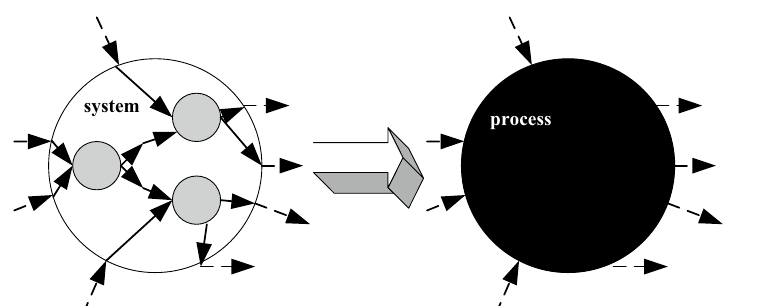
Fig. 3 Simplification of complex material product